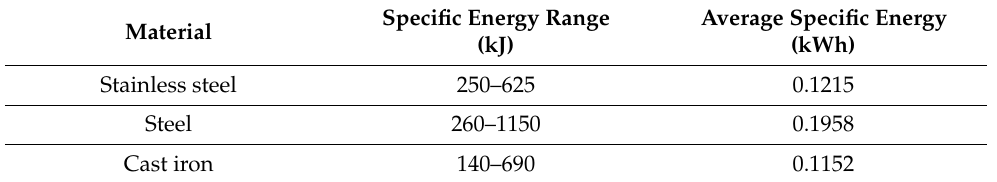
Table 2. Energy requirements for machining